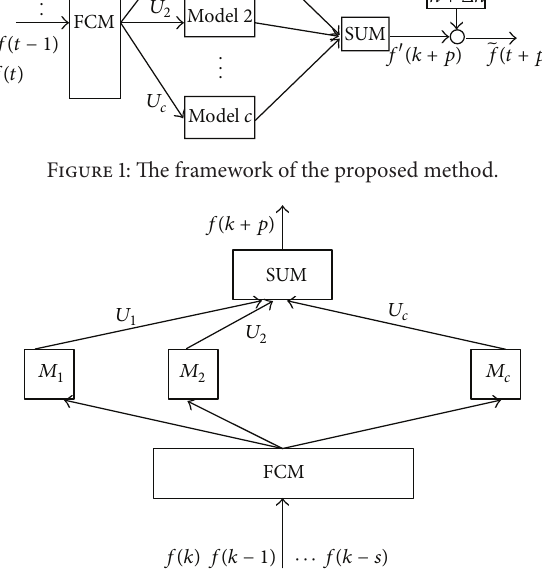
Figure 2: The architecture of